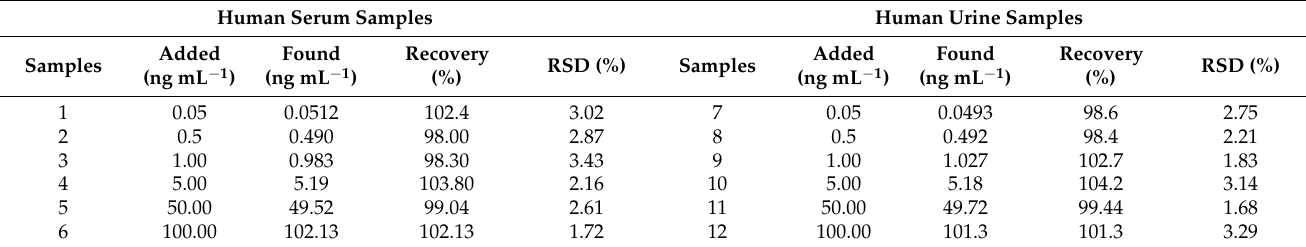
Table 2. The results of CEA detection in the human serum samples and human urine samples. Human Serum Samples Human Urine